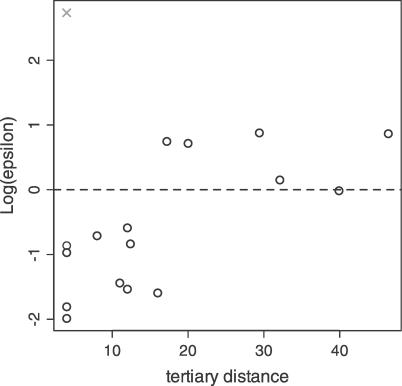
The Nature of Glycan Interactions Depends on Their Intramolecular DistancePotential PNGSs that were identified by the disequon model as having significant interactions with other PNGSs were mapped to a structural model of HIV-1 gp120. Intramolecular distances between interacting PNGSs were measured using the visualization software UCSF Chimera [53]. When an asparagine residue corresponding to a PNGS was not present in the structural model, the distance between pairs was approximated by 4.0 Å times the number of residues separating the PNGSs, to a maximum of five residues. If the number of residues exceeded five, then the unmapped pair was omitted from the analysis.